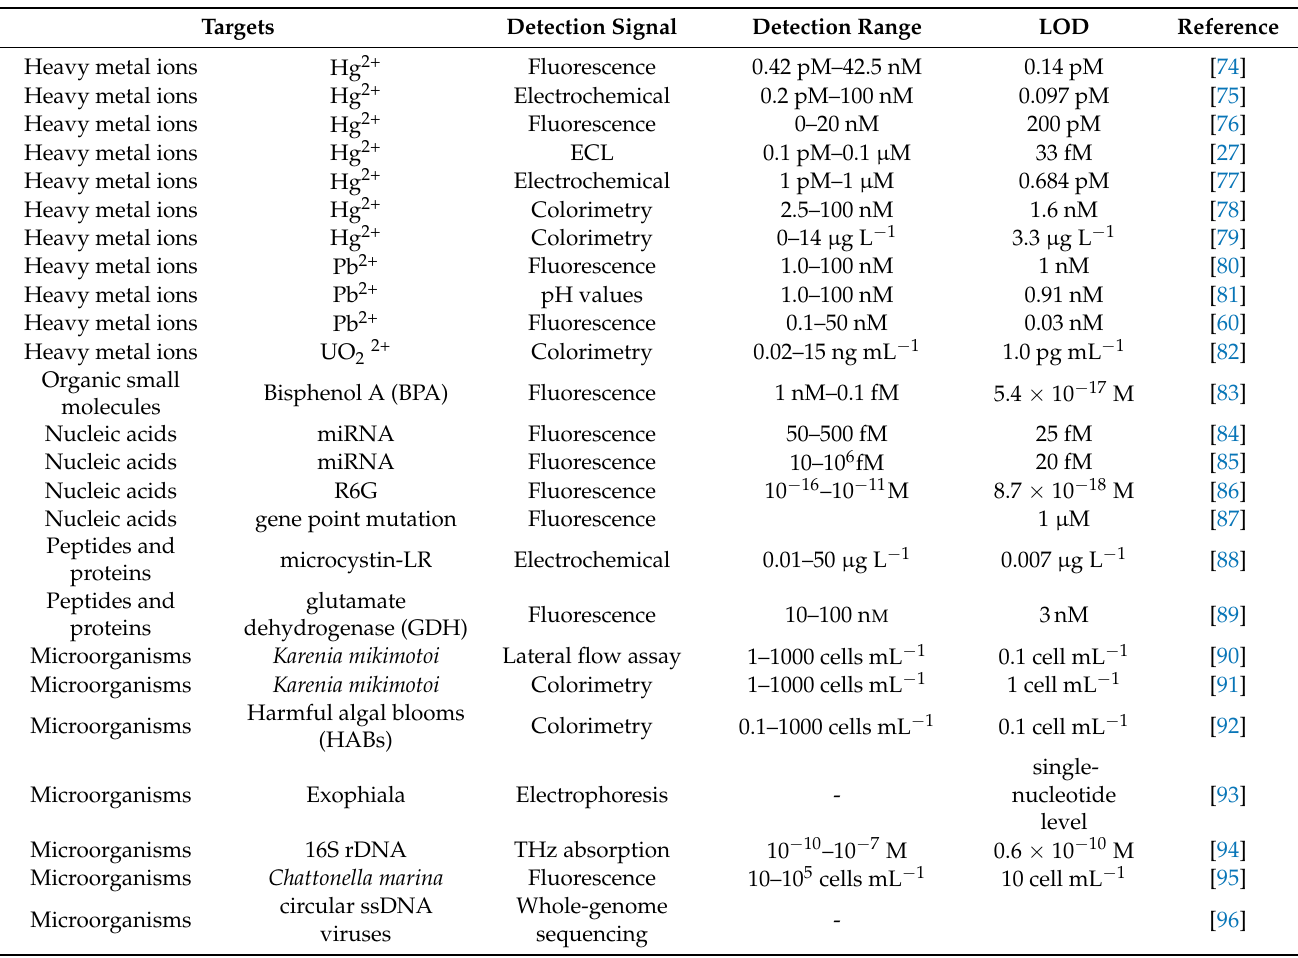
Table 2. Overview of RCA assays for the detection of targets in aqueous